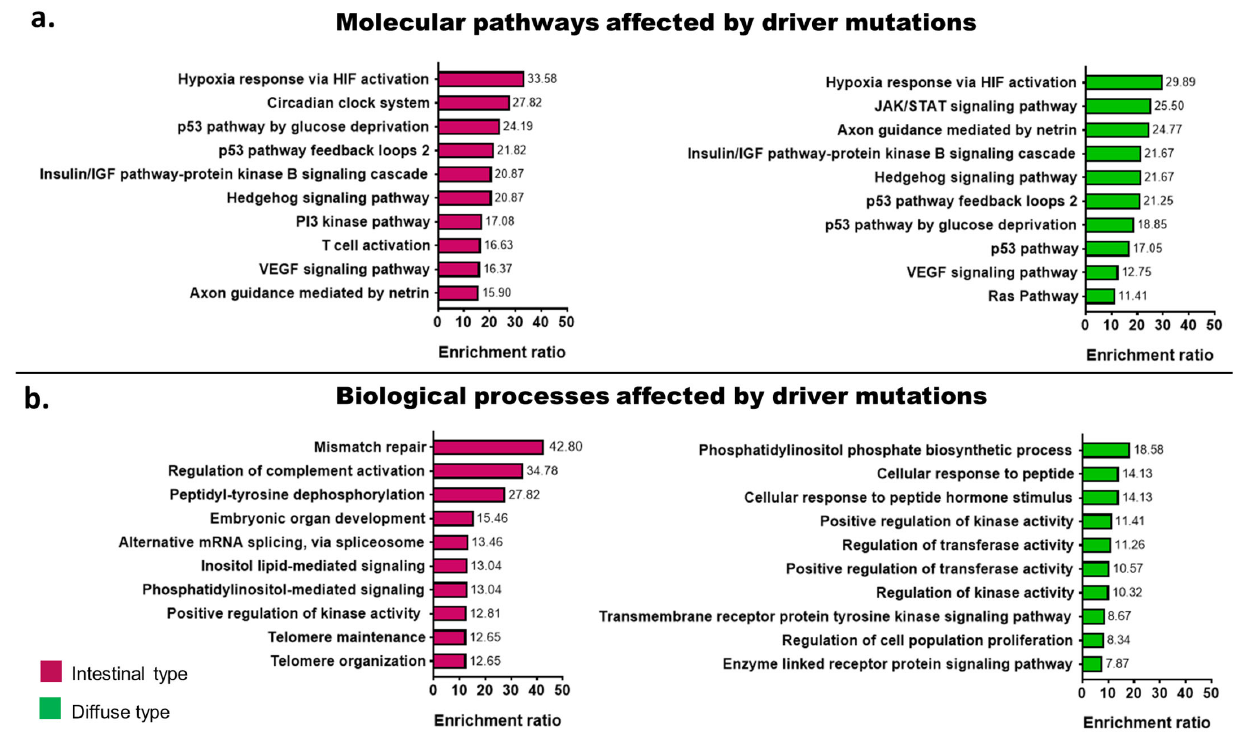
Figure 3. Molecular pathways affected by driver somatic variants from patients with gastric adenocarcinoma treated at The Instituto Nacional de Cancerología of Mexico between January 2019 and January 2020, grouped according to the tumor histology. ( a ) Bar plot representing the molecular pathways affected by driver somatic variants using PANTHER as reference dataset. ( b ) Bar plot representing depicting the biological processes affected by driver somatic variants, using as reference the Gene Ontology dataset.